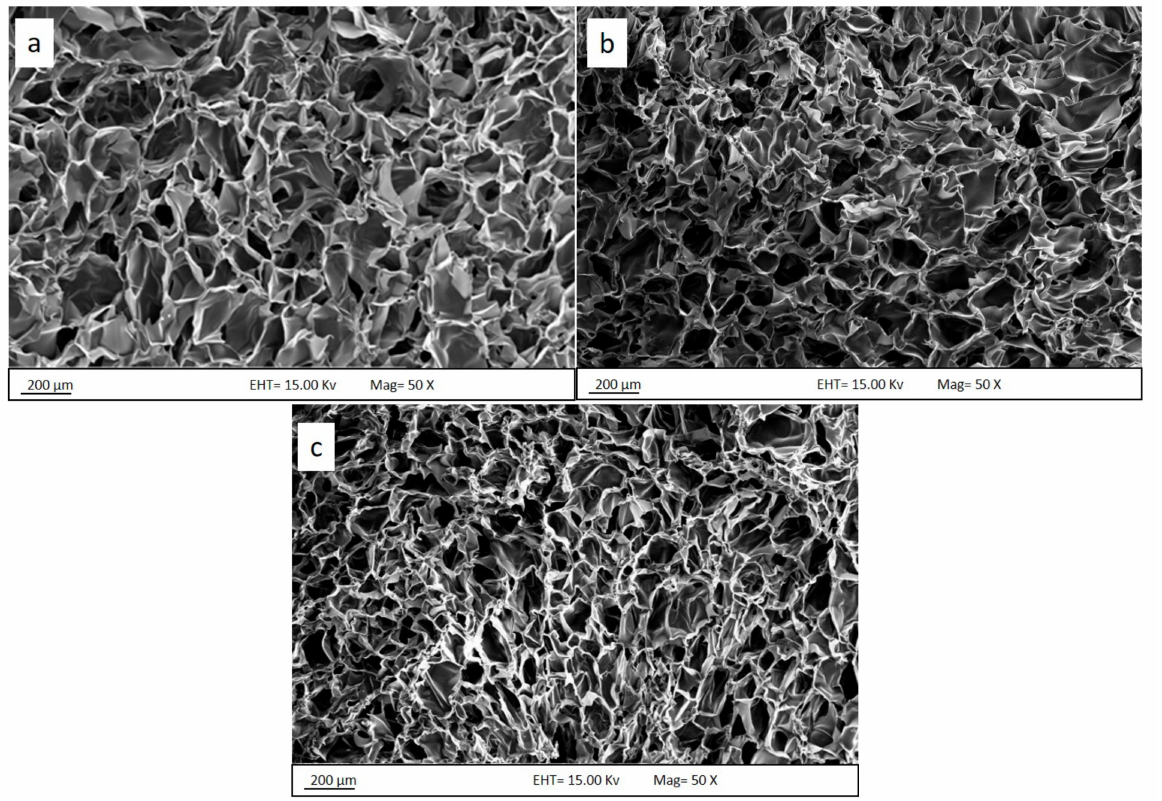
Figure 5. Cross-sectional FESEM images of the membrane foam in chitosan–gelatin composition ratios of ( a ) 1:3, ( b ) 1:5, and ( c )